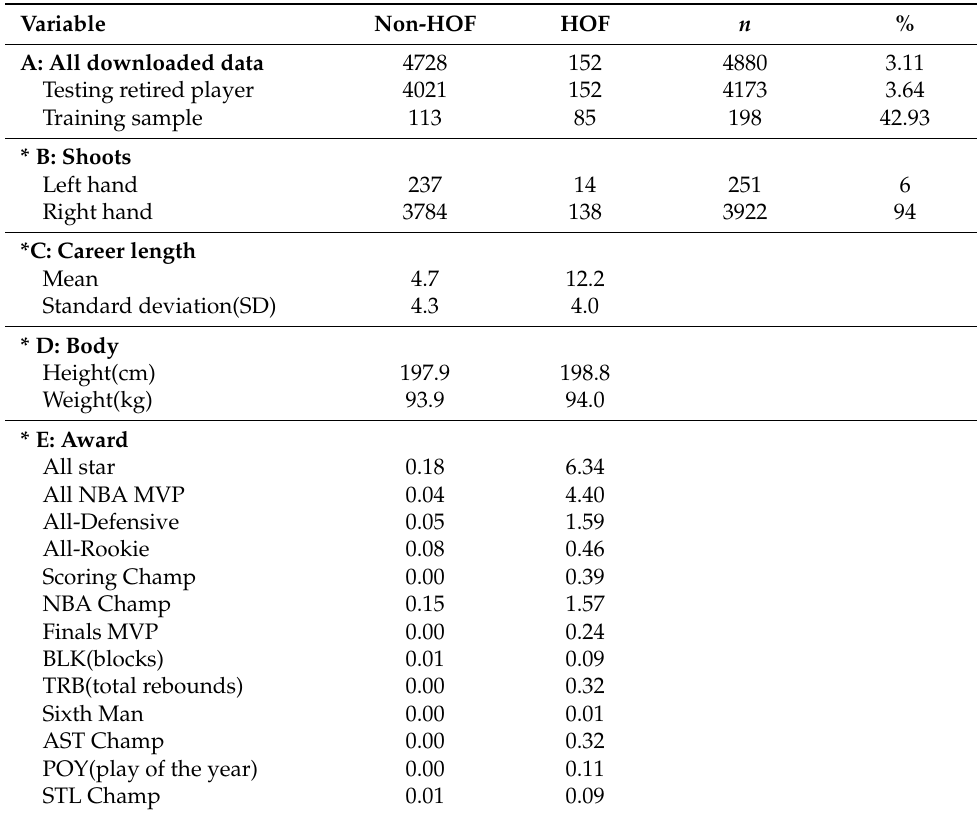
Table 1. Comparison of demographic data of the study